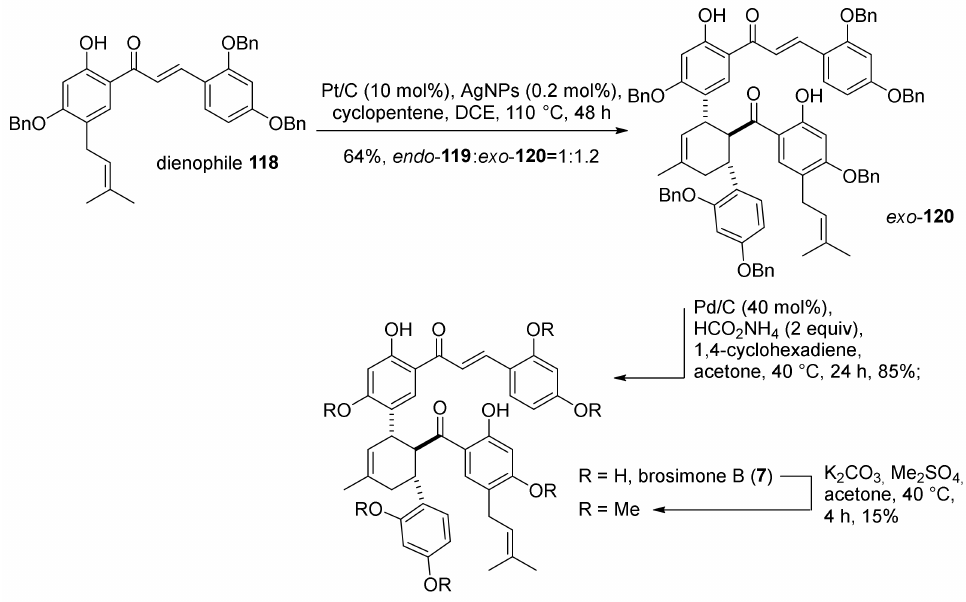
Figure 38. Dehydrogentive Diels–Alder cycloaddition towards brosimone B ( 7 ). Bn = benzyl.